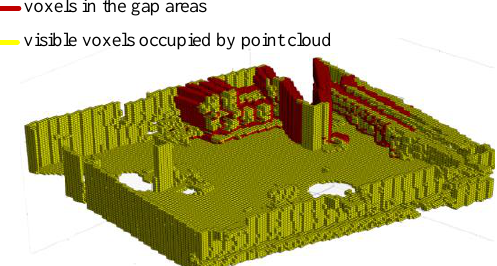
Figure 4. Voxelization of the test data set and detected gap areas